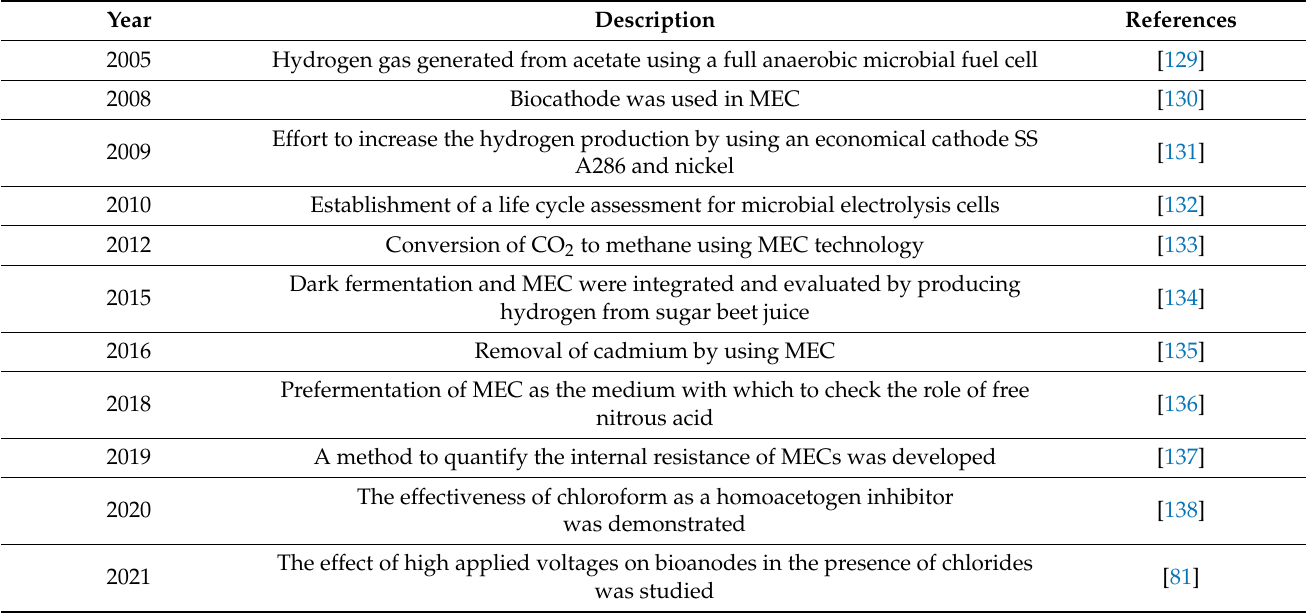
Table 4. Chronological development of microbial electrolysis cell (MEC) technology from 2005 to